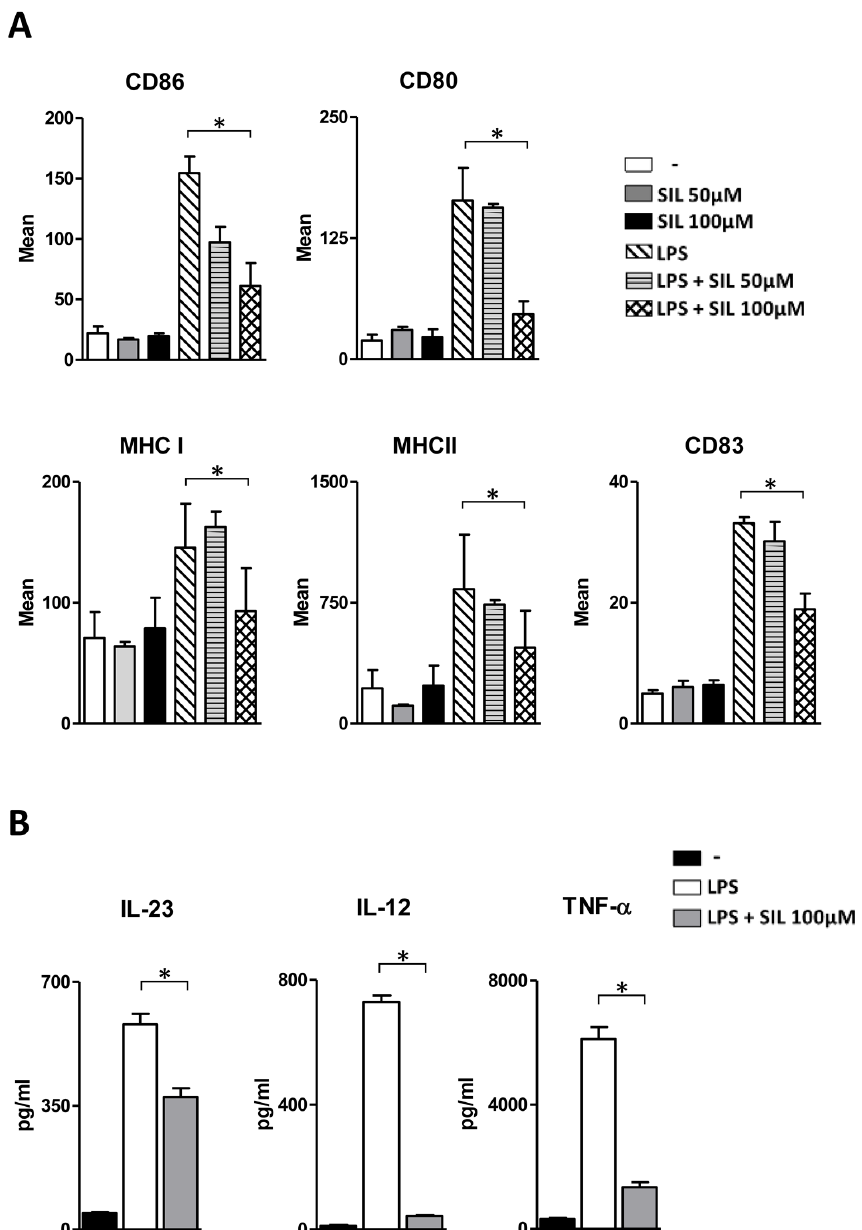
Figure 1. Silibinin significantly suppresses the upregulation of costimulatory and MHC molecules and cytokine production during the maturation process of DC. ( A ) Human monocyte-derived DC were cultured for five days in IL-4 and GM-CSF-enriched medium and stimulated overnight with LPS in the presence or absence of Silibinin at different concentrations (50 or 100 µM). LPS-stimulated DC were used as positive controls for DC maturation. The expression of surface molecules (CD86, CD80, CD83, MHC I, and MHC II) was analyzed using flow cytometry and represented as histograms with the mean fluorescence intensity. Results are expressed as the mean ± standard deviation (SD) of three independent experiments performed. ( B ) Human monocyte-derived DC were cultured for five days in IL-4 and GM-CSF-enriched medium and stimulated overnight with LPS in the presence or absence of Silibinin at 100 µM. Culture supernatants were collected after 24 h and the levels of the proinflammatory cytokines IL-23, IL-12, and TNF- α were determined by ELISA. Results are expressed as the mean ± SD of three independent experiments performed. Statistical analysis was performed using GraphPad Prism (version 5.0, GraphPad Software, San Diego, CA, USA).* p < 0.05 was considered statistically significant.